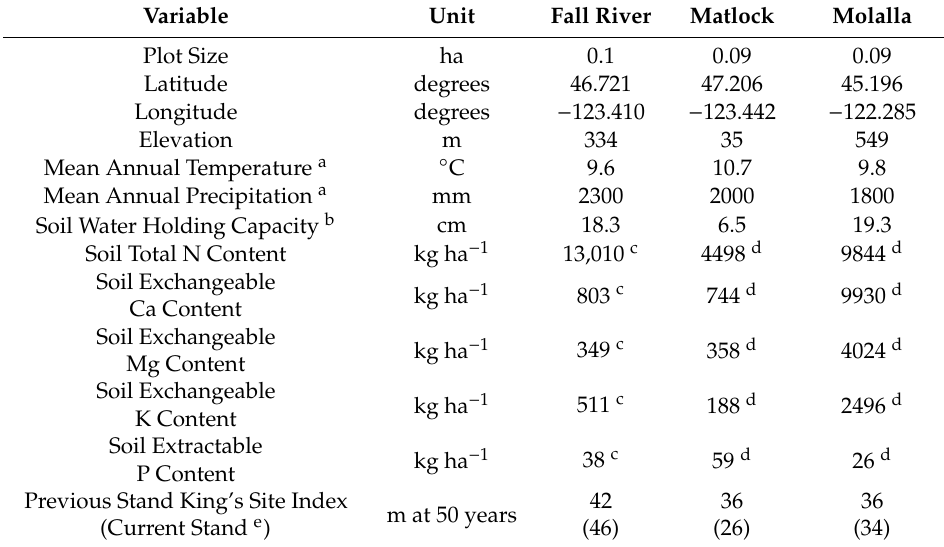
Table 1. Descriptive site variables and pre-treatment soil data to 1-m